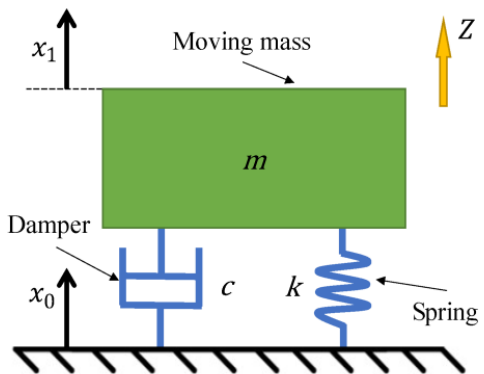
Figure 2. Equivalent model of electromagnetic velocity sensor.